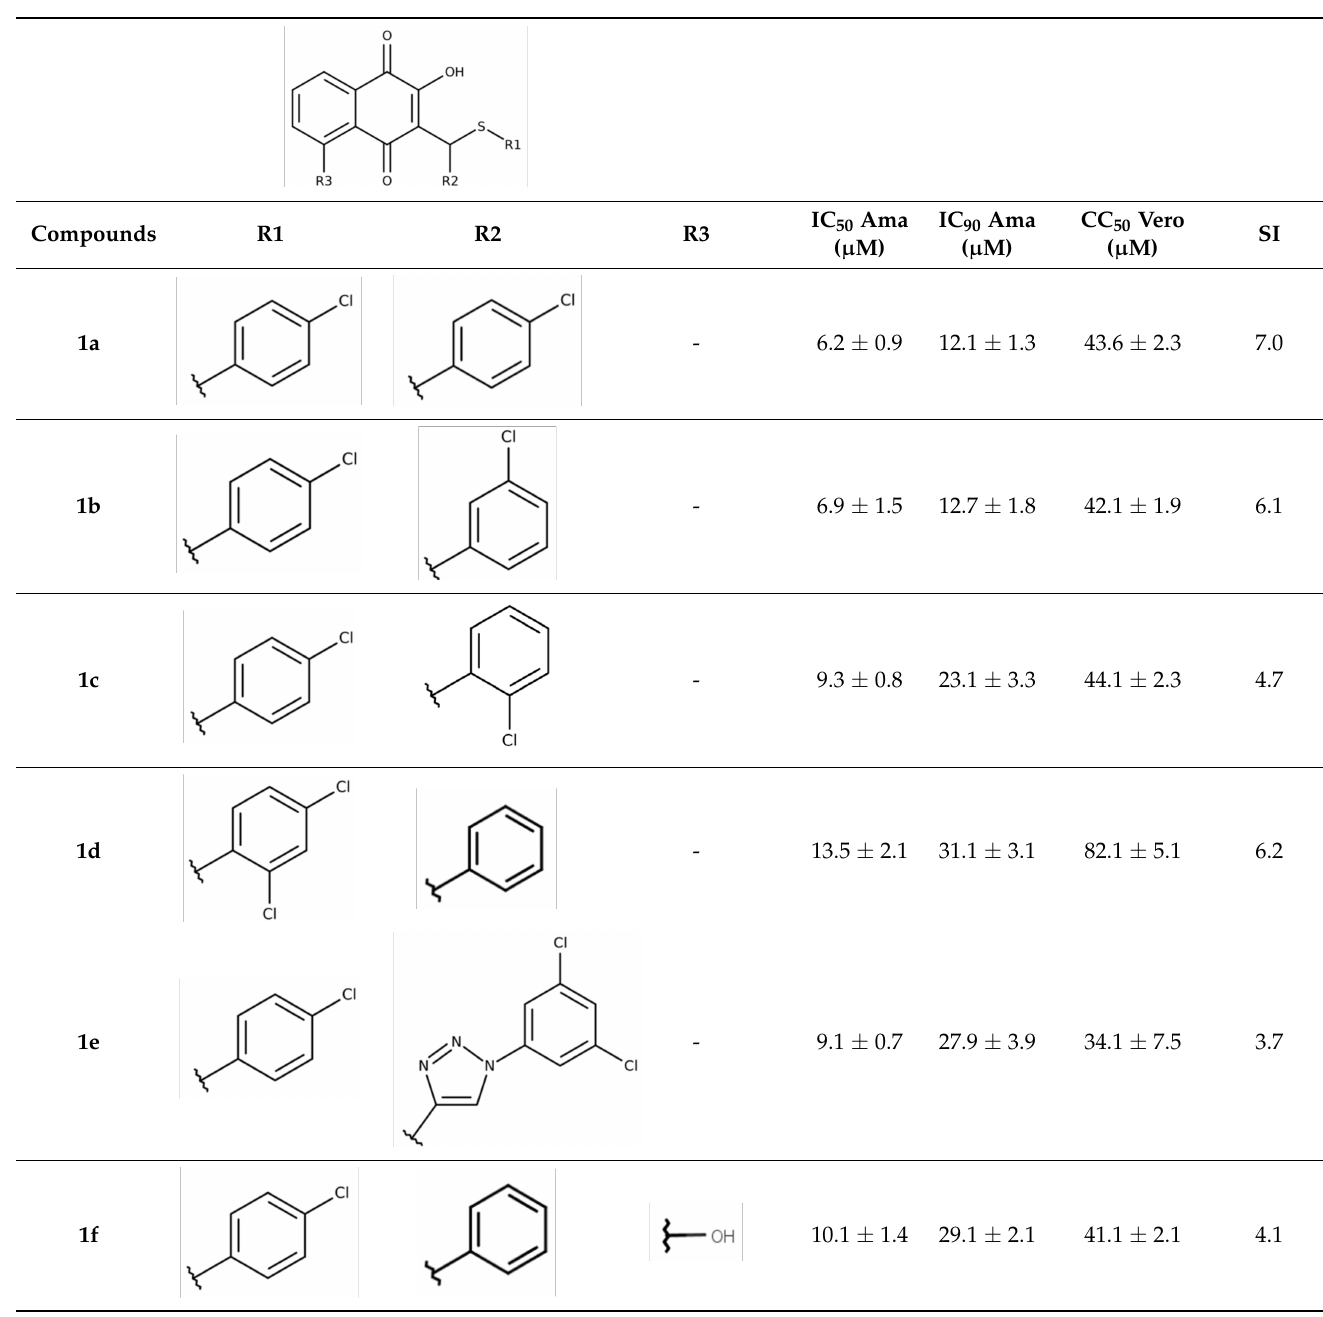
Table 2. Trypanocidal activity and structure activity relationship (SAR) of 1,4- naphthoquinone derivatives. The effect of changes in R-groups against intracellular amastigotes of T. cruzi (Dm28c-Luc clone).